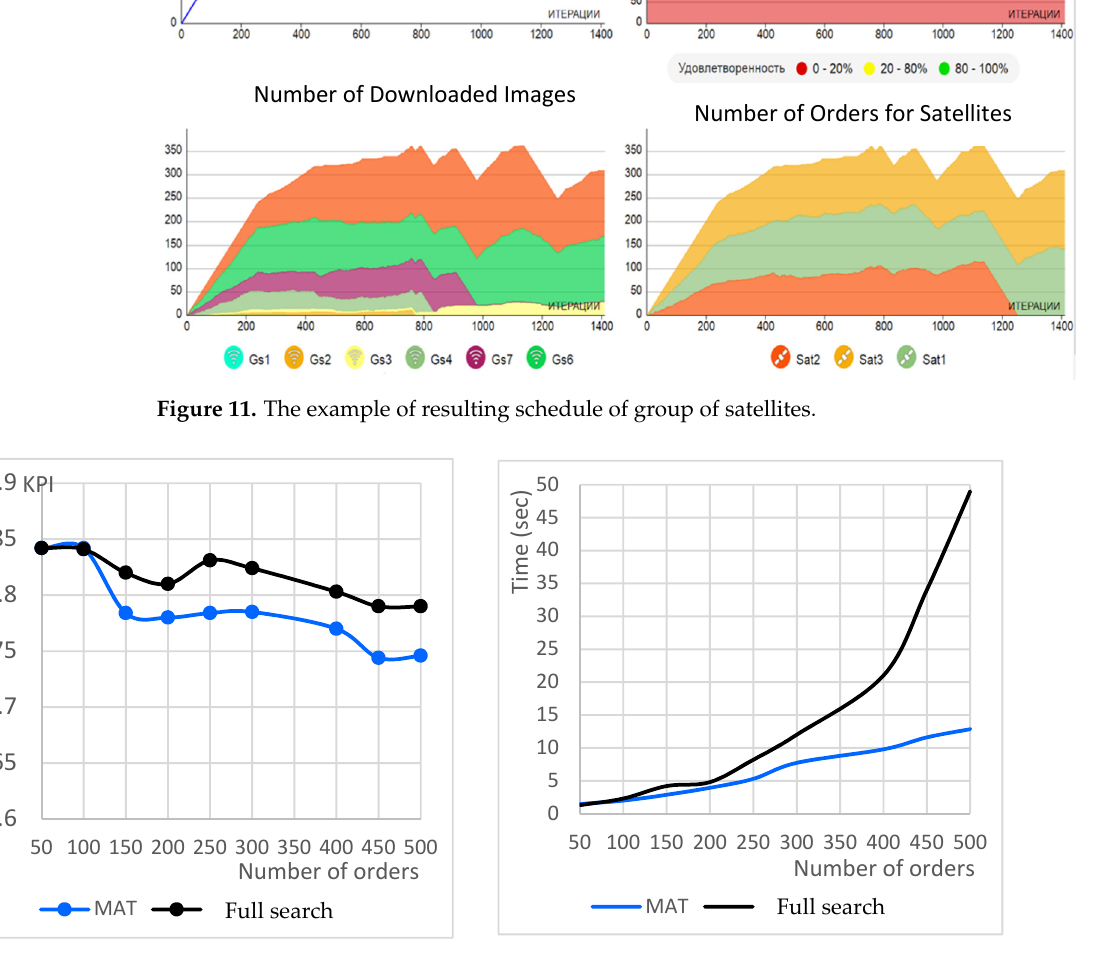
Figure 12. Quality and computational time achieved using the developed method (blue line) com- paring with the full combinatorial search (black line).